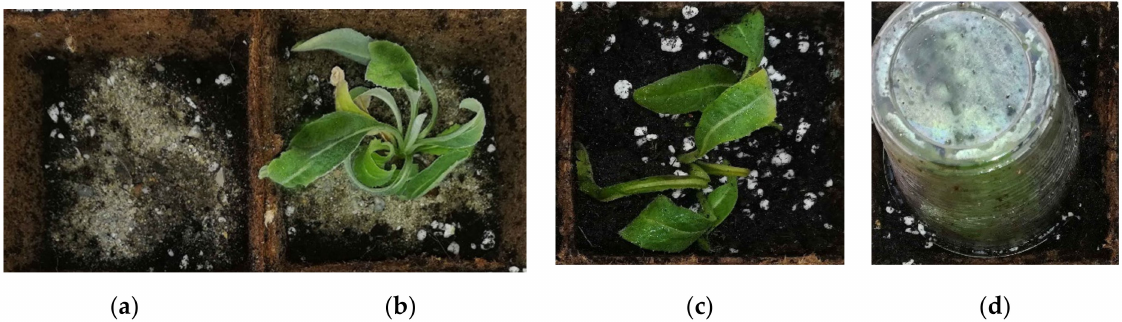
Figure 4. Four organic planting pots with progressive phase of transplants of the mycorrhizal treatment: ( a ) mycorrhizal inoculum; ( b ) root system in direct contact with the mycorrhizal inoculum; ( c ) root system covered with peat; and ( d ) plant from the in vitro culture covered with a plastic cup to keep high relative humidity.